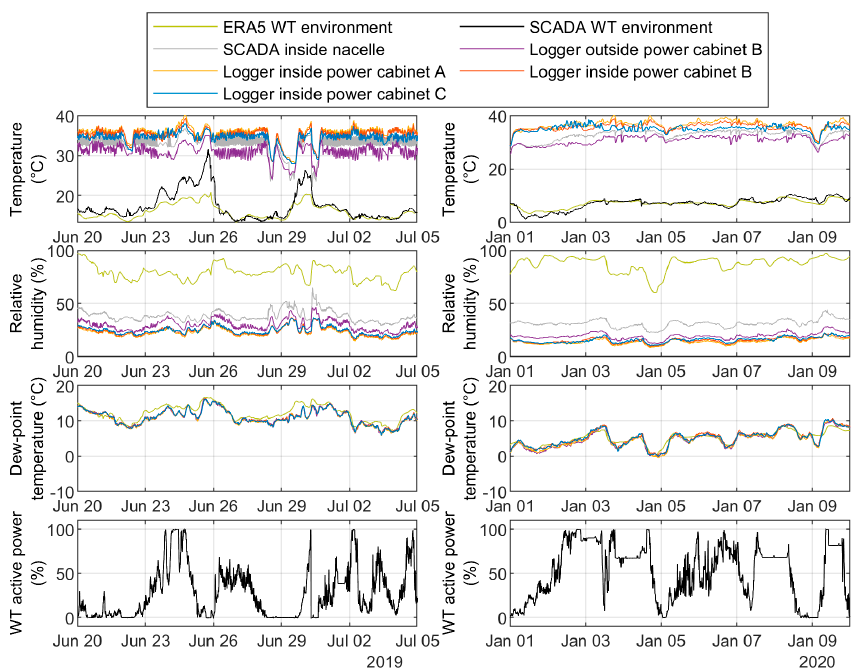
Figure 8. Segments of the logger, SCADA and ERA5 data presented in Figure 7 from an offshore wind turbine in the North Sea with a liquid-cooled converter located in the nacelle.